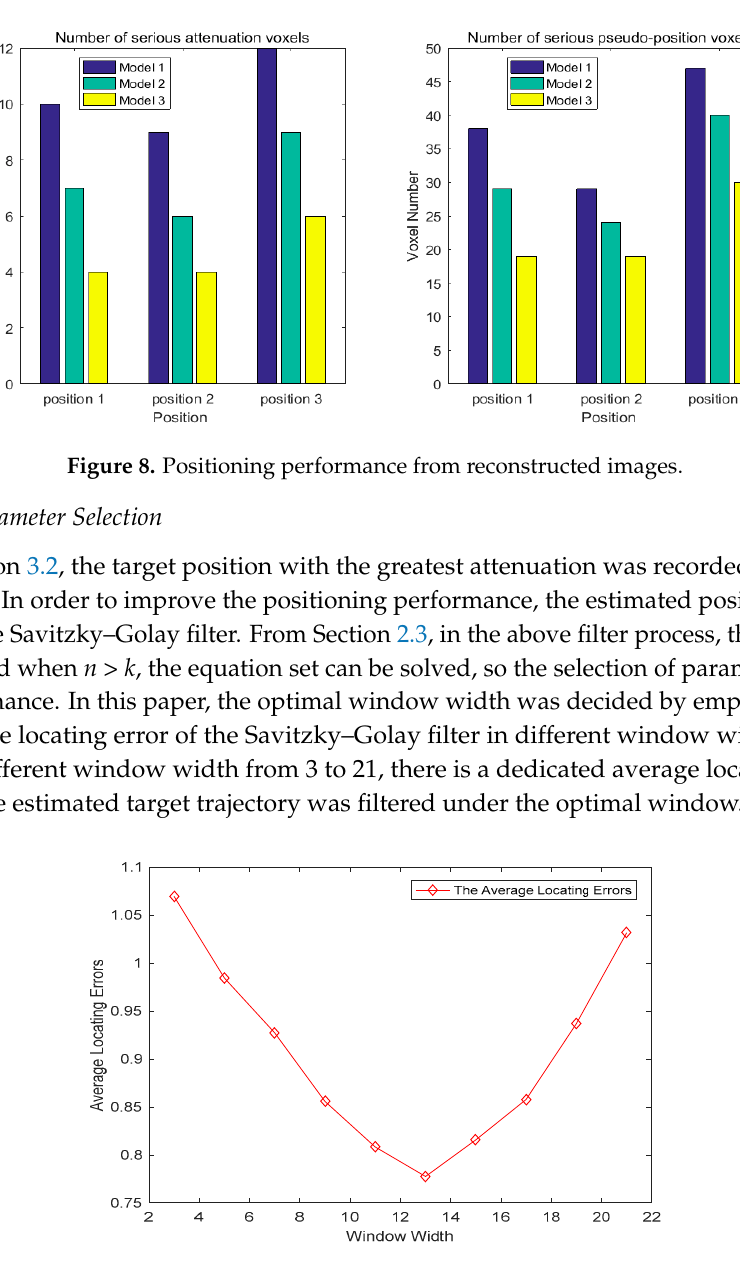
Figure 9. The average location error curve.